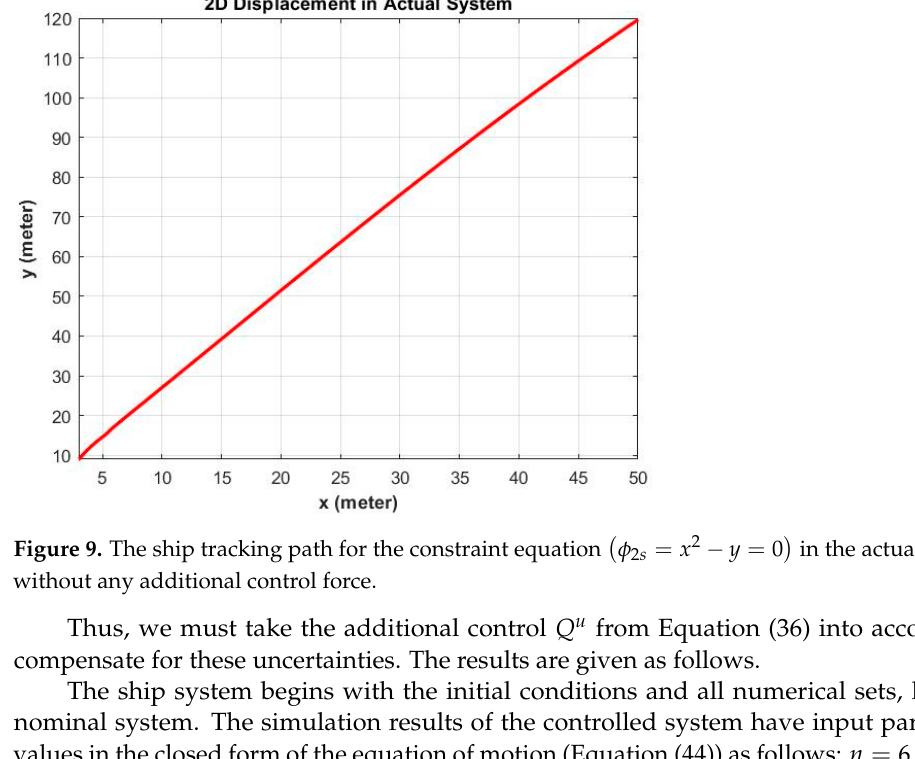
( ) 2 0 x y φ = − = in the actual system 2s